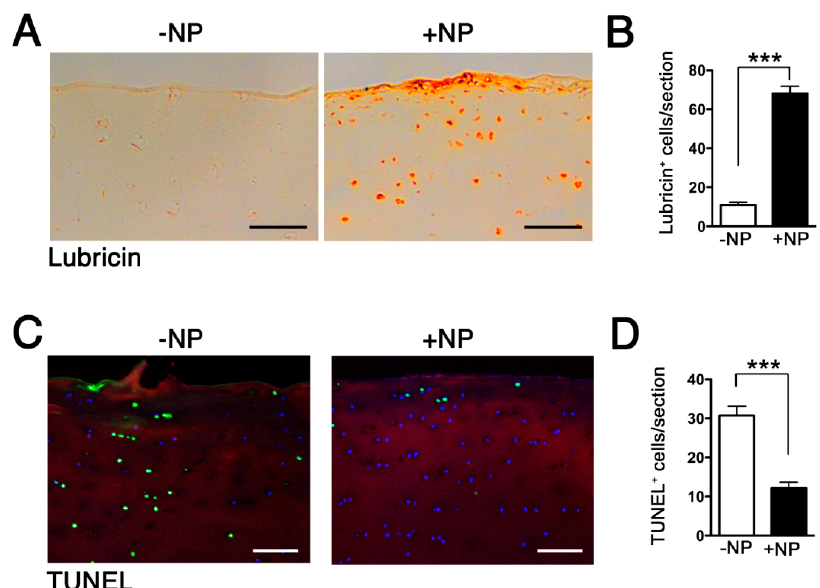
Figure 6. HA-coated p5RHH-WNT16 mRNA NPs (generated at 1 µg of mRNA and 10 µmol of p5RHH) were incubated with 5 mm 2 cartilage discs derived from human OA knee joints. After 48 h, cartilage explants were washed, processed, and examined for lubricin expression ( A , B ) and terminal deoxynucleotidyl transferase and nick-end labeling (TUNEL)+ cells ( C , D ). Scale bar = 100 µm. The numbers of Lubricin+ and TUNEL+ cells/cartilage section were enumerated. Values represent mean ± SEM. Data were derived from 6–8 cartilage sections, from 4–6 independent human cartilage explants. *** p < 0.001.